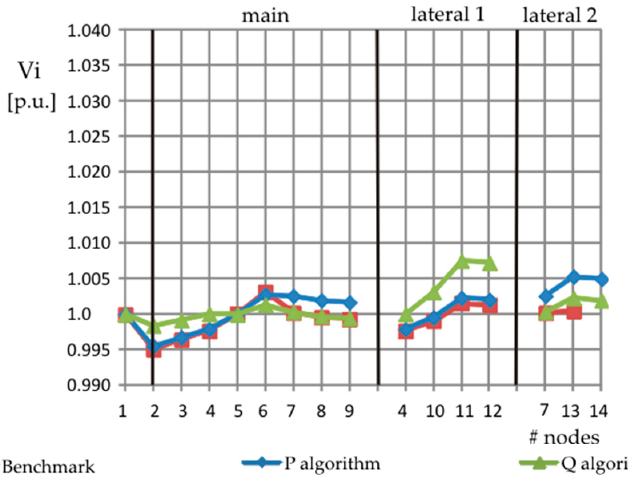
Figure 14 : Voltage profiles of the Benchmark and proposed VOP with three VCZs for Case X — DG: feeder 1.